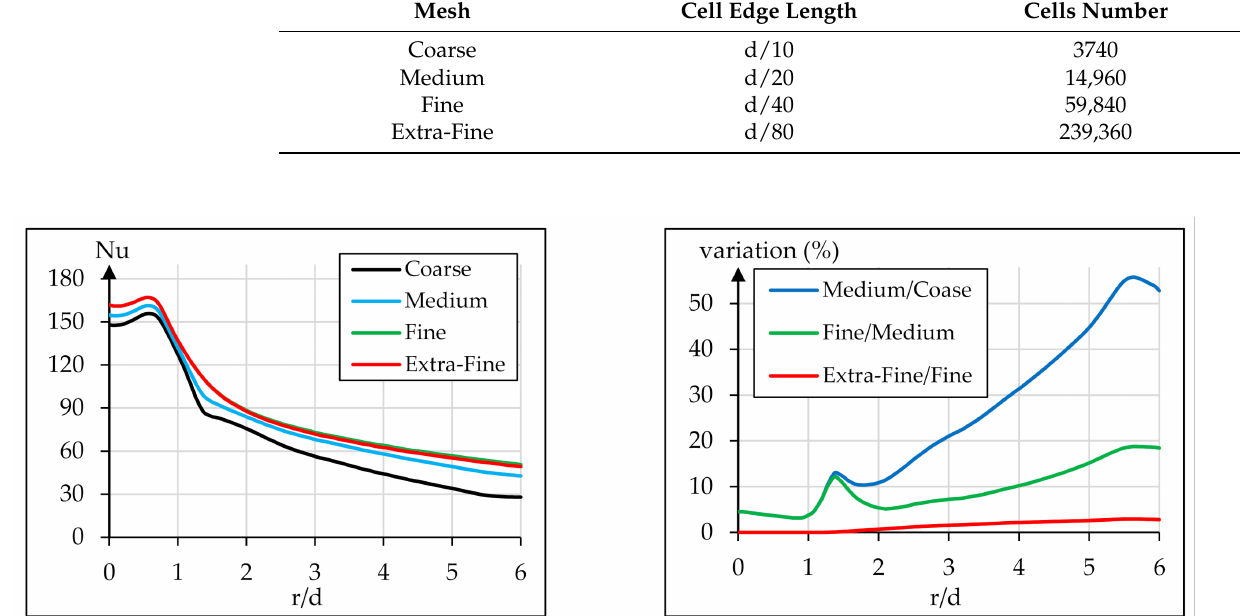
Figure 10. Nusselt number distribution for the four meshes (on the left) and Nusselt number variation (on the